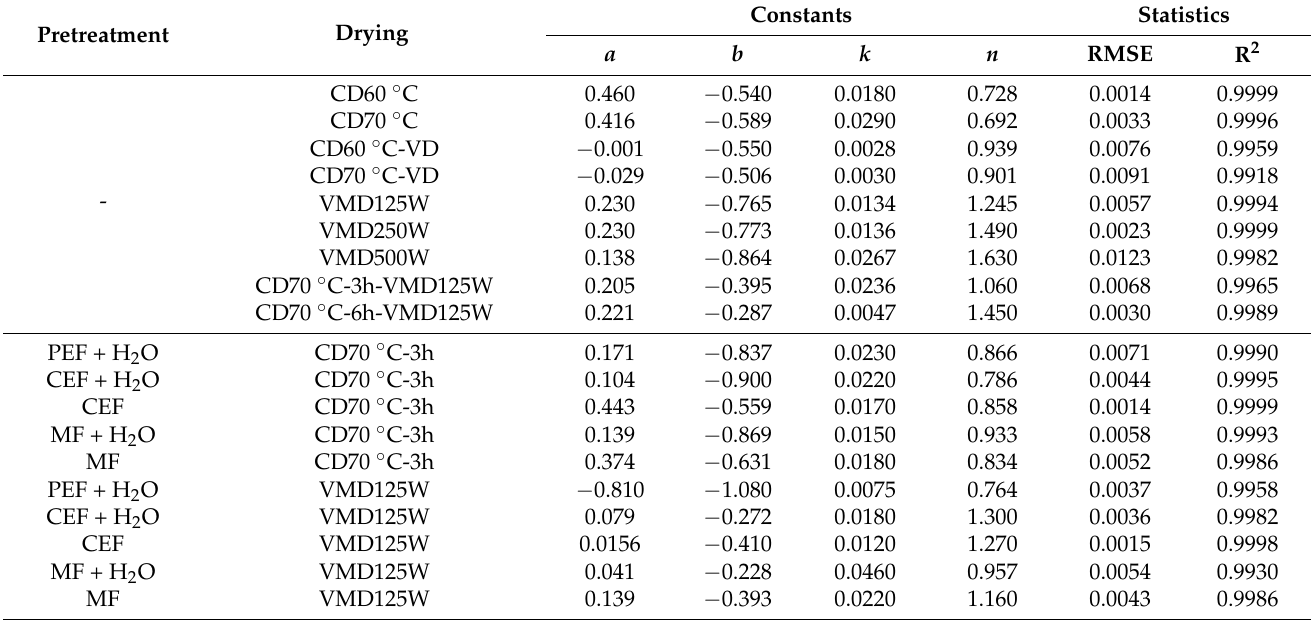
Table 2. Weibull model parameters ( a, b, k, and n ) together with the root mean square error (RMSE) and the coefficient of determination (R 2 ) according to the used drying and pretreatment